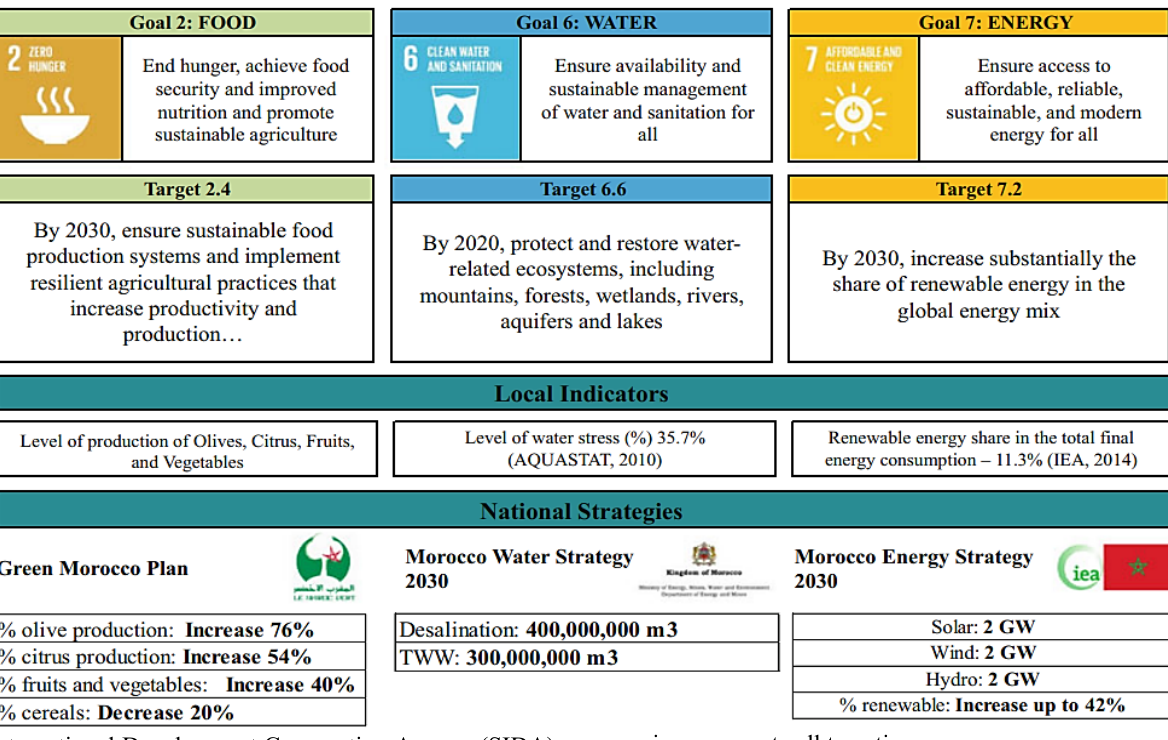
Figure 1 WEF SDGs and Moroccan local indicators and strategies (Source: Water-Energy-Food Sustainable Development Goals in